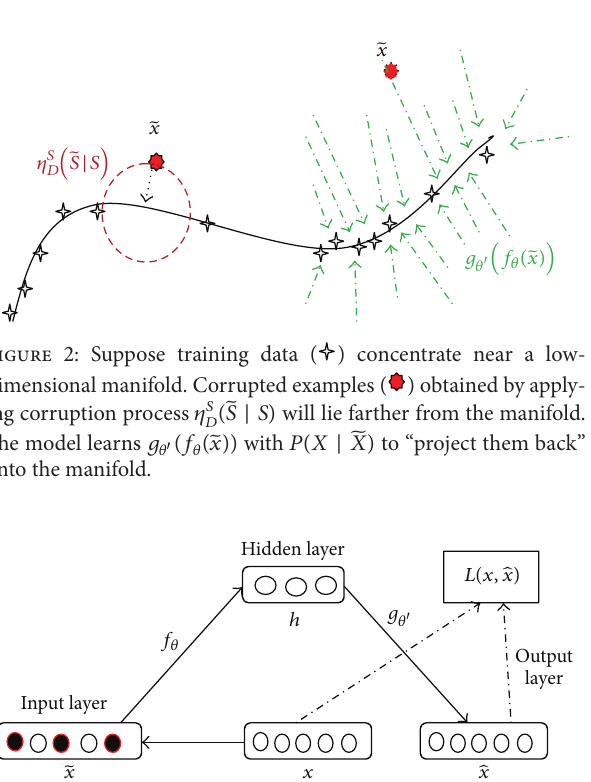
Figure 3: Basic denoising autoencoder (DAE) scheme. An empty circle depicts a single neuron. A filled circle depicts corrupted units in input